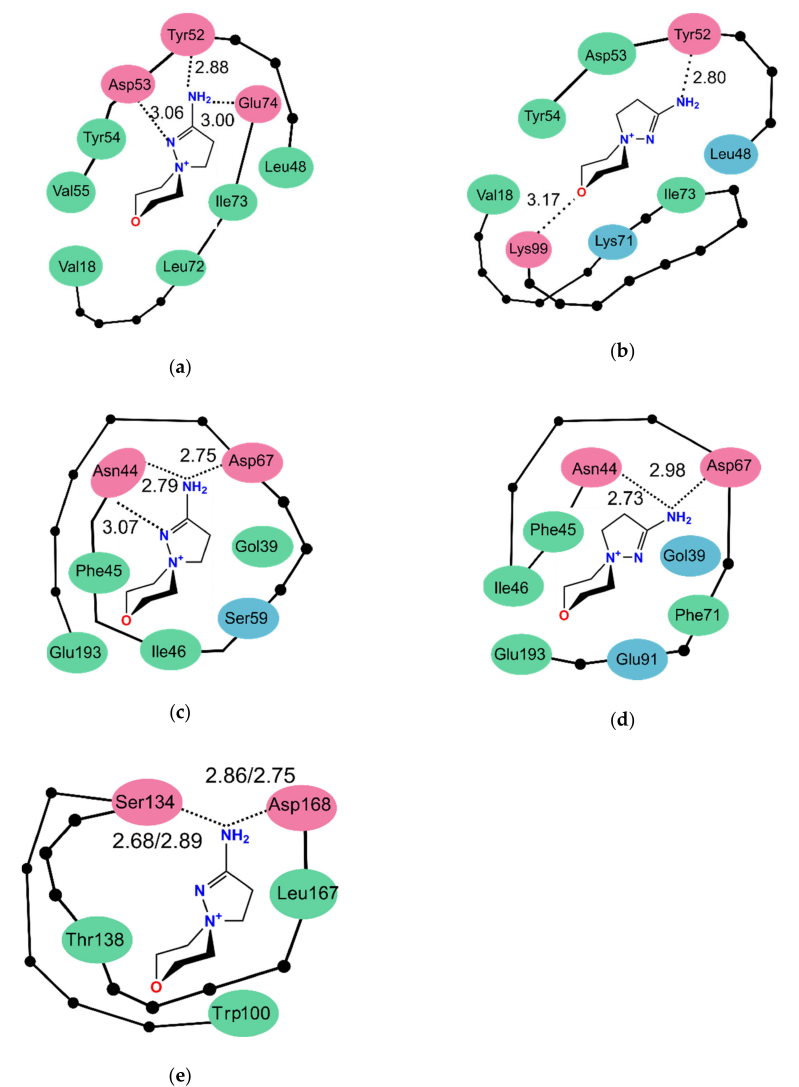
Figure 6. Schematic representation of the interactions between 2-amino-8-oxa-1,5-diazaspiro[4.5]dec-1-ene-5-ammonium and the residues within binding pockets of 1NBU (type A ( a ), type B ( b )), 4XT4 (type A ( c ) and type B ( d )), and 5ICJ ( e ). The colors of the residues indicate the character of bonding: pink correspond to H-bonds, green—hydrophobic interactions, blue—electrostatic interactions. H-bonds and their distances are depicted with dotted lines. Left —column corresponds to type A cations, and the right —to type B